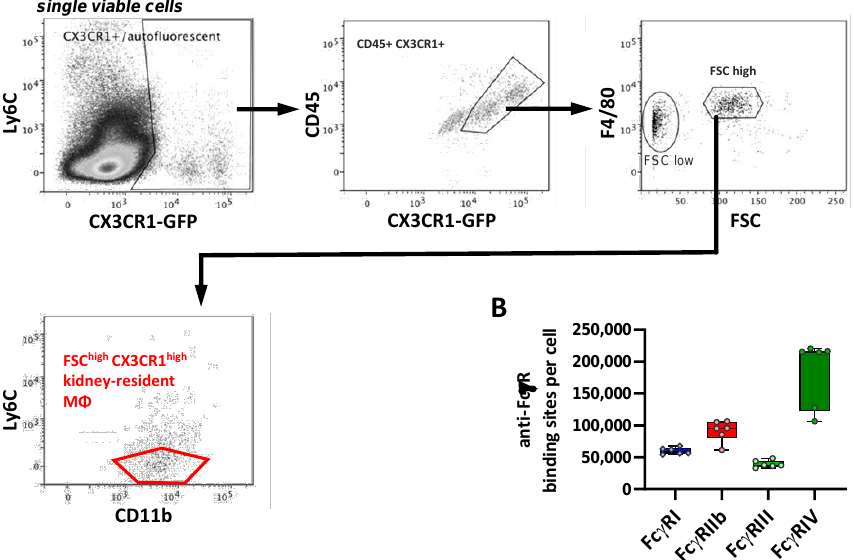
Figure 7. Characterization of Fc γ R expression on kidney-resident macrophages. ( A ) Gating strategy for the identification of kidney-resident M Φ . Single viable cells from enzymatically digested kidneys of B6 cx3cr1 +/gfp mice were examined for cx3rcr1 promoter-driven GFP and CD45 expression. CD45 + CX3CR1 + cells were then analyzed with respect to F4/80 expression and cell size, as reflected by their forward light scatter characteristics (FSC). In the F4/80 + FSC high population, we then selected cells that were negative for Ly6C but positive for CD11b. ( B ) Depicted are the number of anti-Fc γ R-binding sites per cell as a quantitative correlate of Fc γ R expression. Data are presented as box plots depicting the median and interquartile range and whiskers showing extremes together with all single values; n =